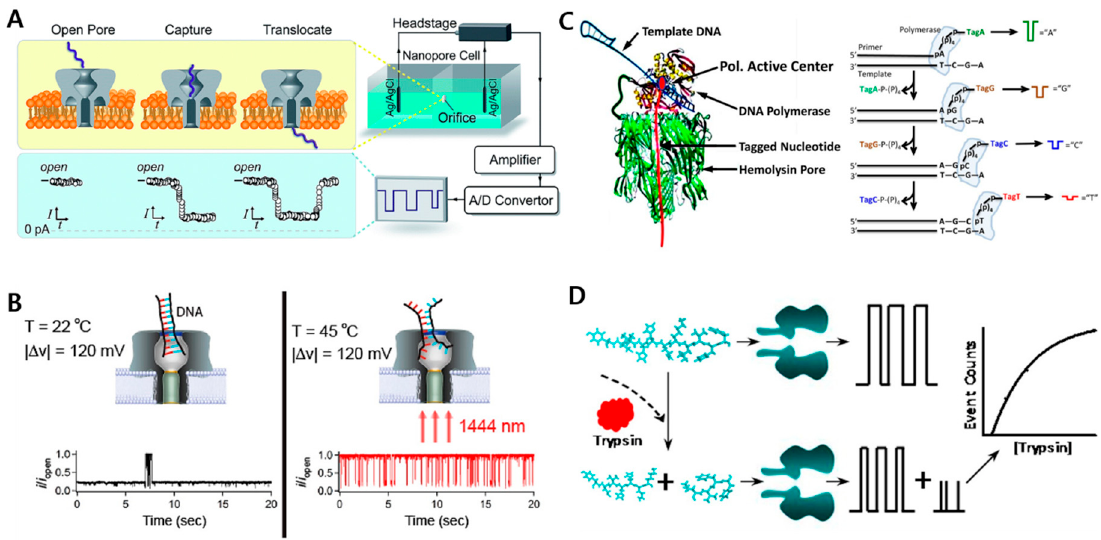
Figure 3. Shows the biological nanopore sensor experimental setup. ( A ) The generic experimental setup for single-molecule studies using a nanopores [25]. (Reproduced with permission from Ying et al., Analyst 2014. Copyright© 2014 Royal Society of Chemistry) ( B ) The experimental setup and analysis of DNA unzipping at elevated temperature by using short-wavelength infrared (SWIR) heating methodology [32]. (Reproduced with permission from Christopher E. Angevine et al., Anal. Chem. 2016. Copyright© 2016 American Chemical Society) ( C ) A design for nanopore sensors with phi29 DNA polymerase molecules attached to the α -Hemolysin ( α -HL) pore. The next image shows the sequential detection of tagged nucleotides using sequencing by synthesis (SBS) methodology [37]. (Reproduced with permission from C.W. Fuller et al., PNAS 2016. Copyright© 2016 National Academy of Sciences) ( D ) An indirect strategy to analyze the protein activity. The current before and after trypsin activity is compared [42]. (Reproduced with permission from S. Zhou et al., ACS Sens.